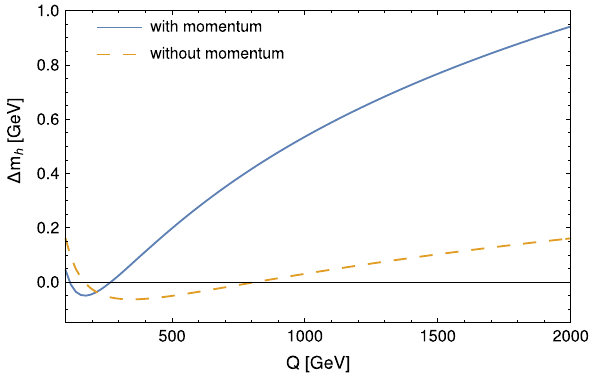
Fig. 1 Differencebetweenthetwo-loopHiggsmasscomputedby SMH ) SPheno − ( m 2 (cid:13) ) SMH – as a function of the renormal- and SPheno – ( m 2 (cid:13) h h isation scale Q , with (blue curve) and without (orange dashed curve) the momentum dependence at two loops in SMH . The Higgs quartic coupling is here λ = 0 . 12604. In SPheno the contributions of the light SM fermions are turned off and the external momentum in the two-loop | routines is set to s = m 2 h